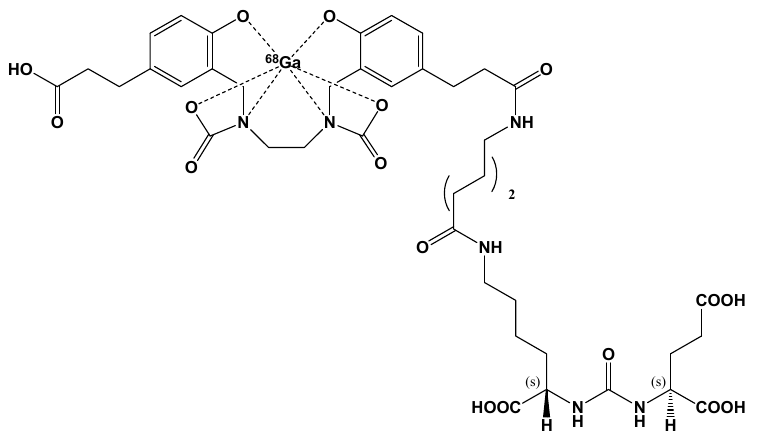
Figure 3. Chemical structure of the radiotracer for PET imaging [ 68 Ga]GaPSMA-11.